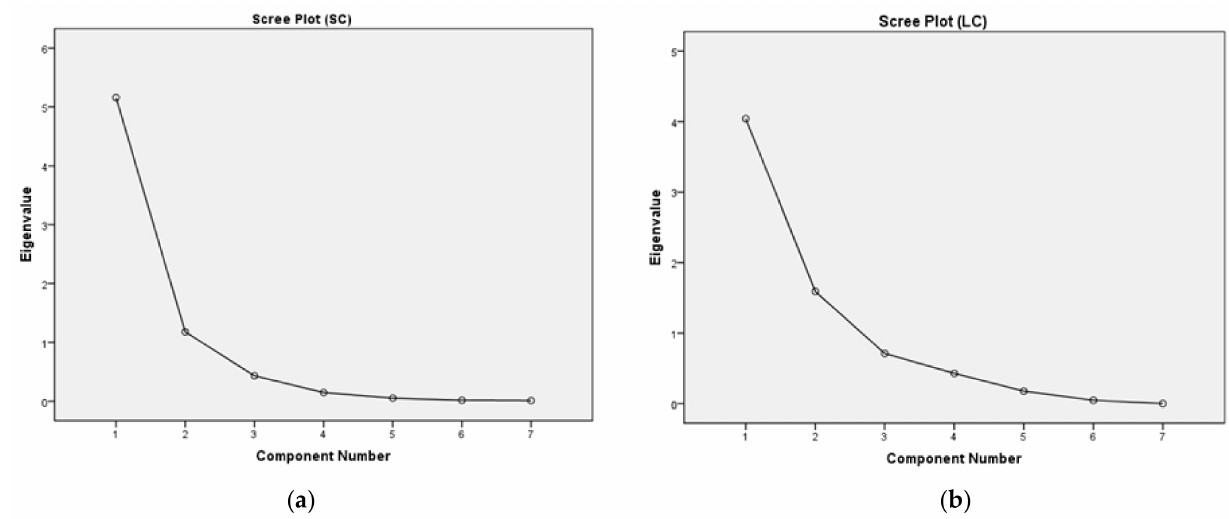
Figure 14. ( a ) Scree plot for the SC group ( b ) scree plot for the LC